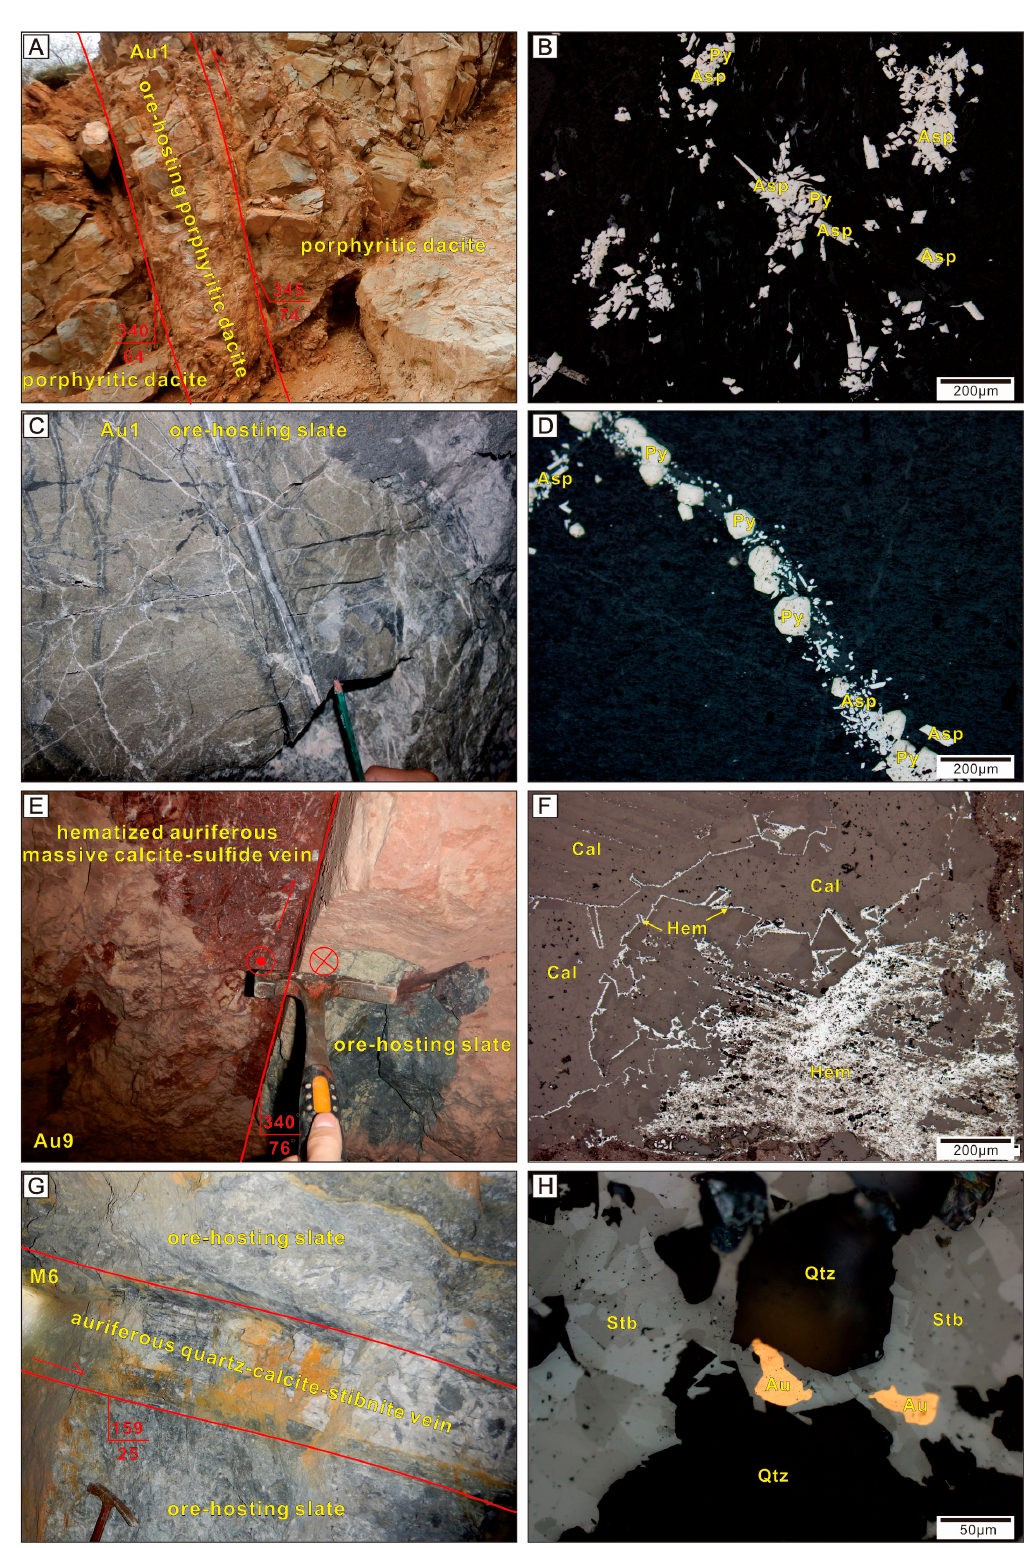
Figure 3. Exposure ( A , C , E , G ) and photomicrographs under reflected light ( B , D , F , H ) showing mineralization styles and mineral assemblages. ( A , B ) Pyrite and arsenopyrite as disseminated aggregates in porphyritic dacite. ( C , D ) Pyrite and arsenopyrite veinlet in slate. ( E , F ) Hematized auriferous calcite veins. ( G , H ) Auriferous quartz-calcite-stibnite vein structurally controlled by NE- trending faults cutting slate and native gold grains occur in cracks and inclusions of stibnite and quartz. Py = pyrite, Asp = arsenopyrite, Stb = stibnite, Au = native gold, Qtz = quartz, Cal = calcite, Hem = hematite.